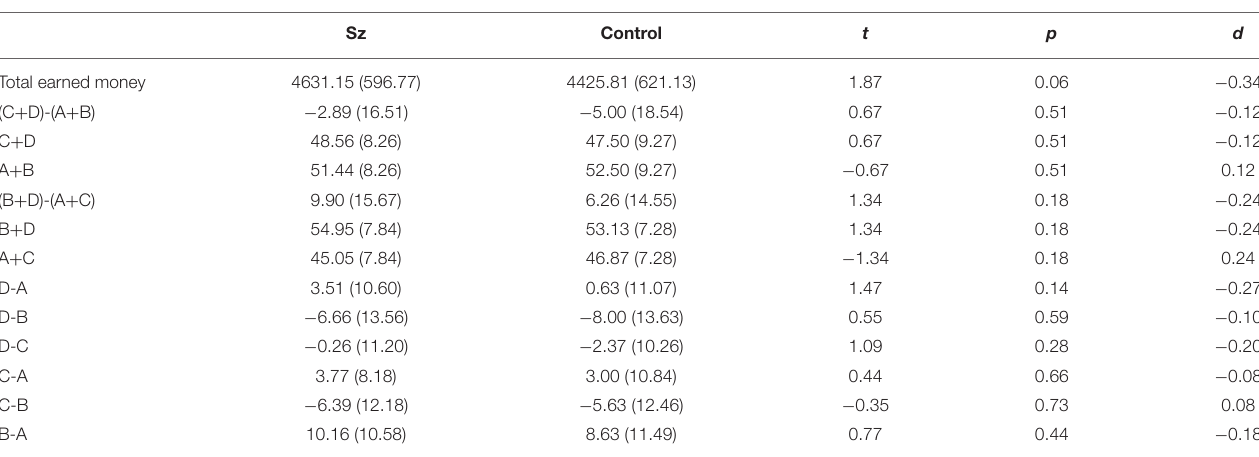
TABLE 2 | IGT performance of Sz and control.